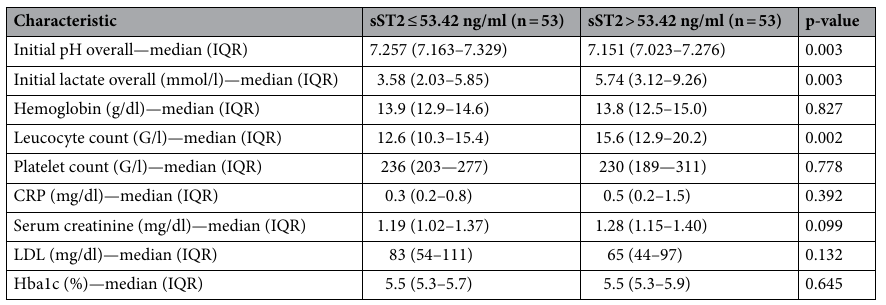
Table 3. Initial laboratory values. CRP C-reactive protein, IQR interquartile range, LDL low-density lipoprotein.